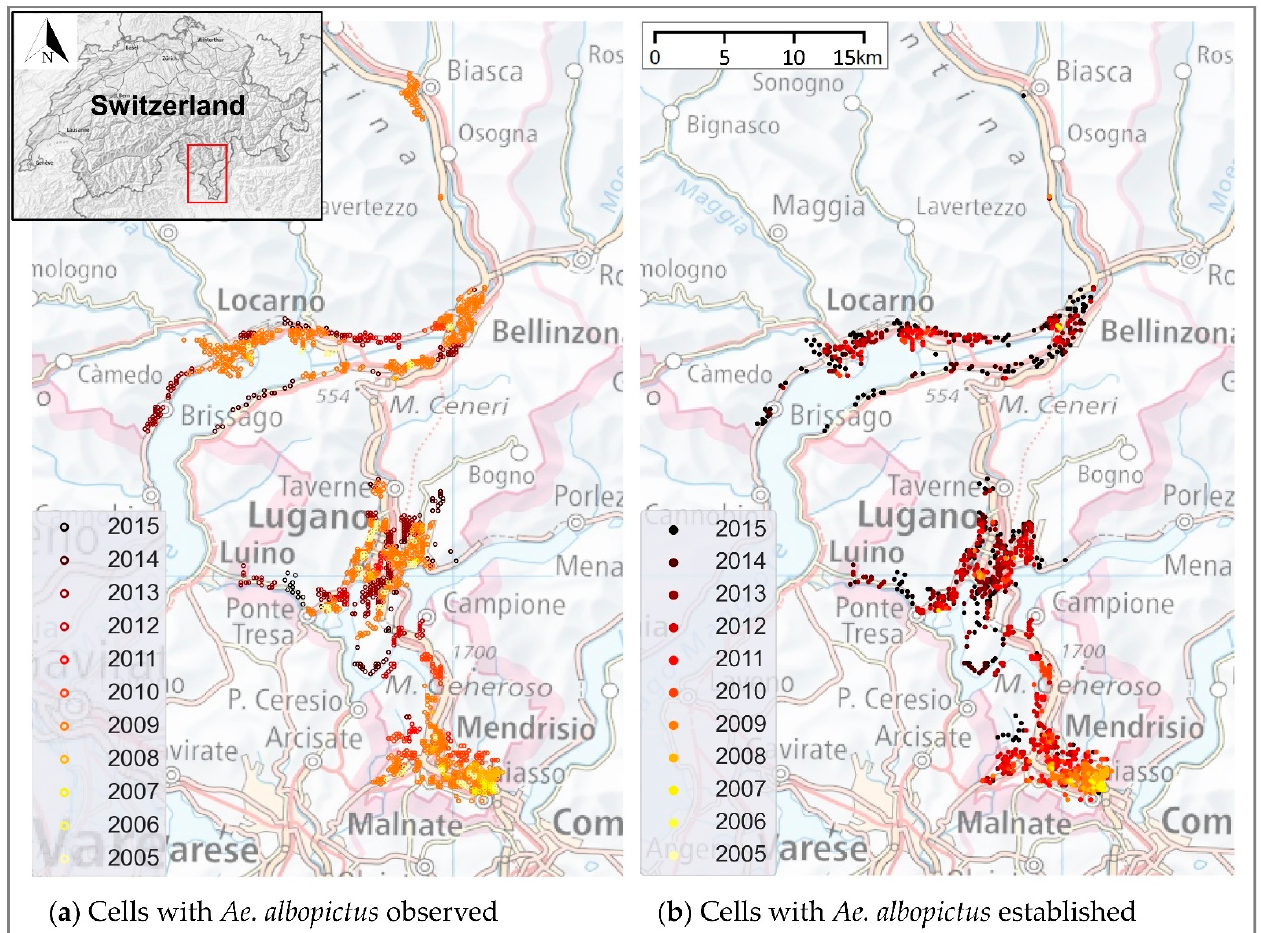
Figure 1. Occurrence of Ae. albopictus in Ticino, Switzerland, from 2005 to 2015. ( a ) The empty dots represent observed cells; ( b ) the solid dots represent cells with establishment of the mosquito. Refer to methods for definition of observed and established cells. Maps modified from https://map.geoadmin.ch/ (accessed on 24 February 2022).